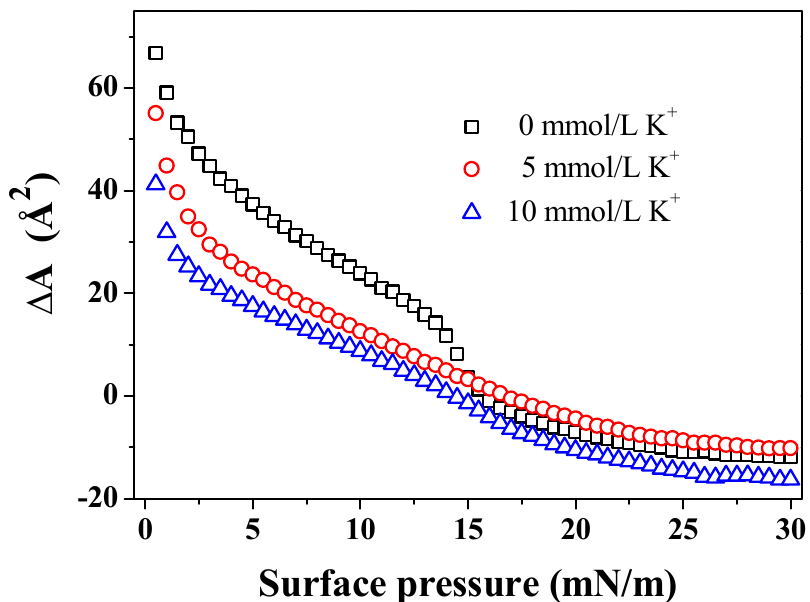
Figure 3. The mean molecular area increment ( ∆𝐴 ) of the DPPC/Chol mixed monolayer caused by AmB in the absence and presence of potassium ions at the same surface pressure. The DPPC/Chol mixed monolayer and the DPPC/Chol/AmB mixed monolayer were compressed to a surface pressure of 15 mN/m and 30 mN/m, and the area of the monolayer was kept constant. We recorded the change in the surface pressure over time, as seen in Figure 4. The surface pressure was decreased or increased until the equilibrium value ( π e ) was reached [56]. Then, ∆ π e was calculated using the formula: ∆ π e = π e - AmB / lipid − π e - lipid , which indicated the change in π e (Table 1). A positive ∆ π e value indicates that the stability of the monolayer was enhanced by AmB, while a negative ∆ π e value suggests that the stability of the monolayer was weakened by AmB [56]. A smaller value of | ∆ π e | means a weaker impact of AmB on the stability of the lipid monolayer.